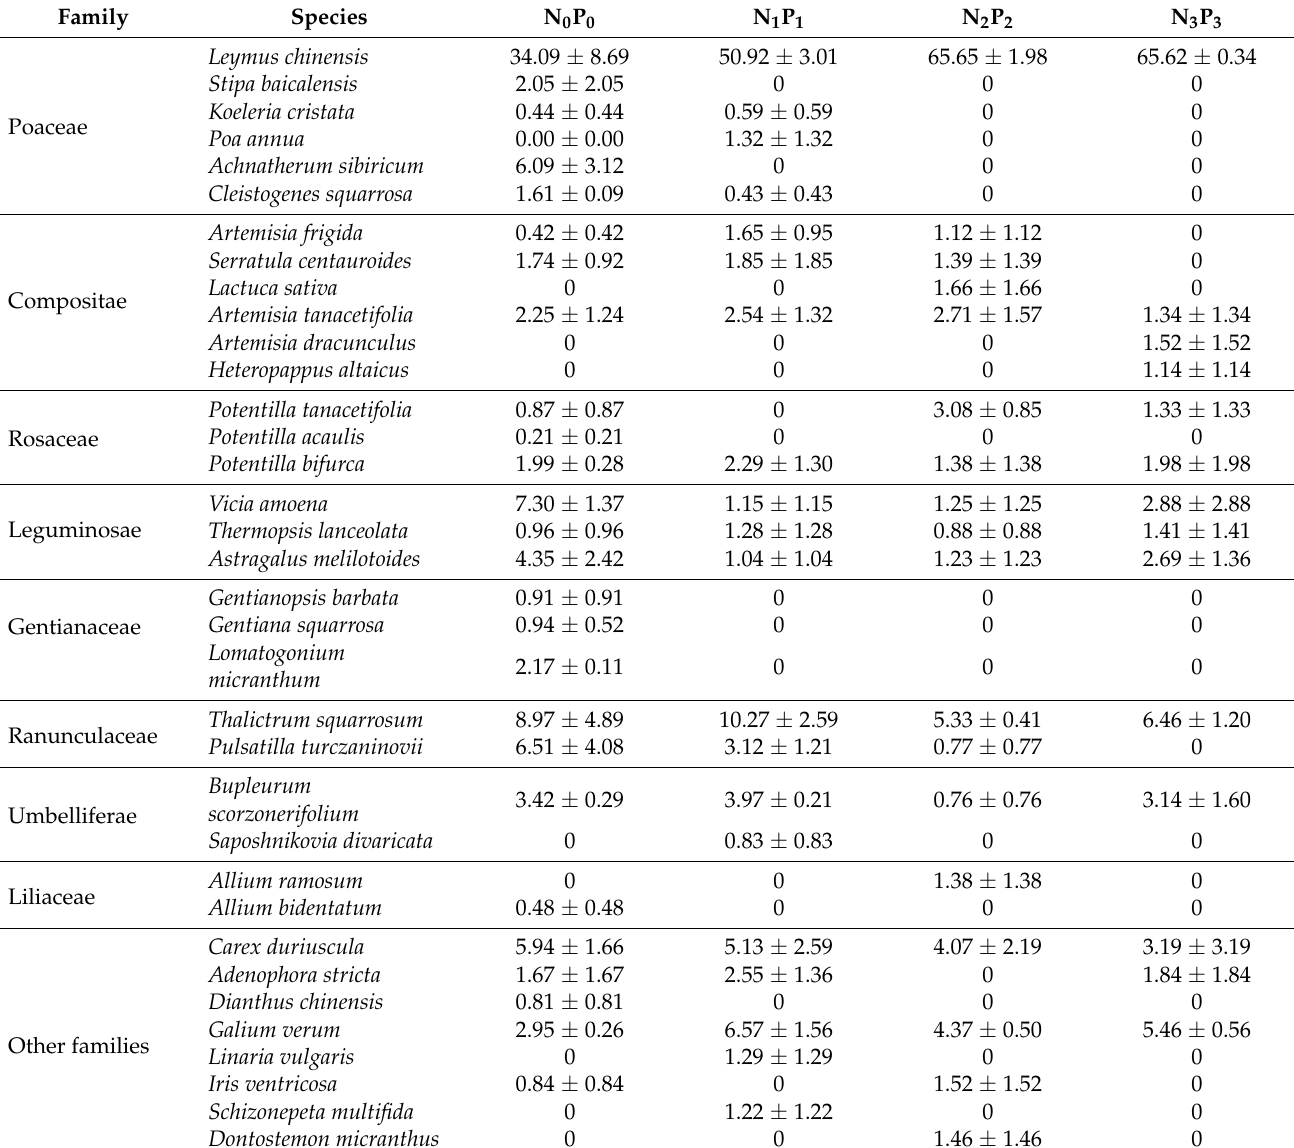
Table 2. Plant species importance values among NP addition